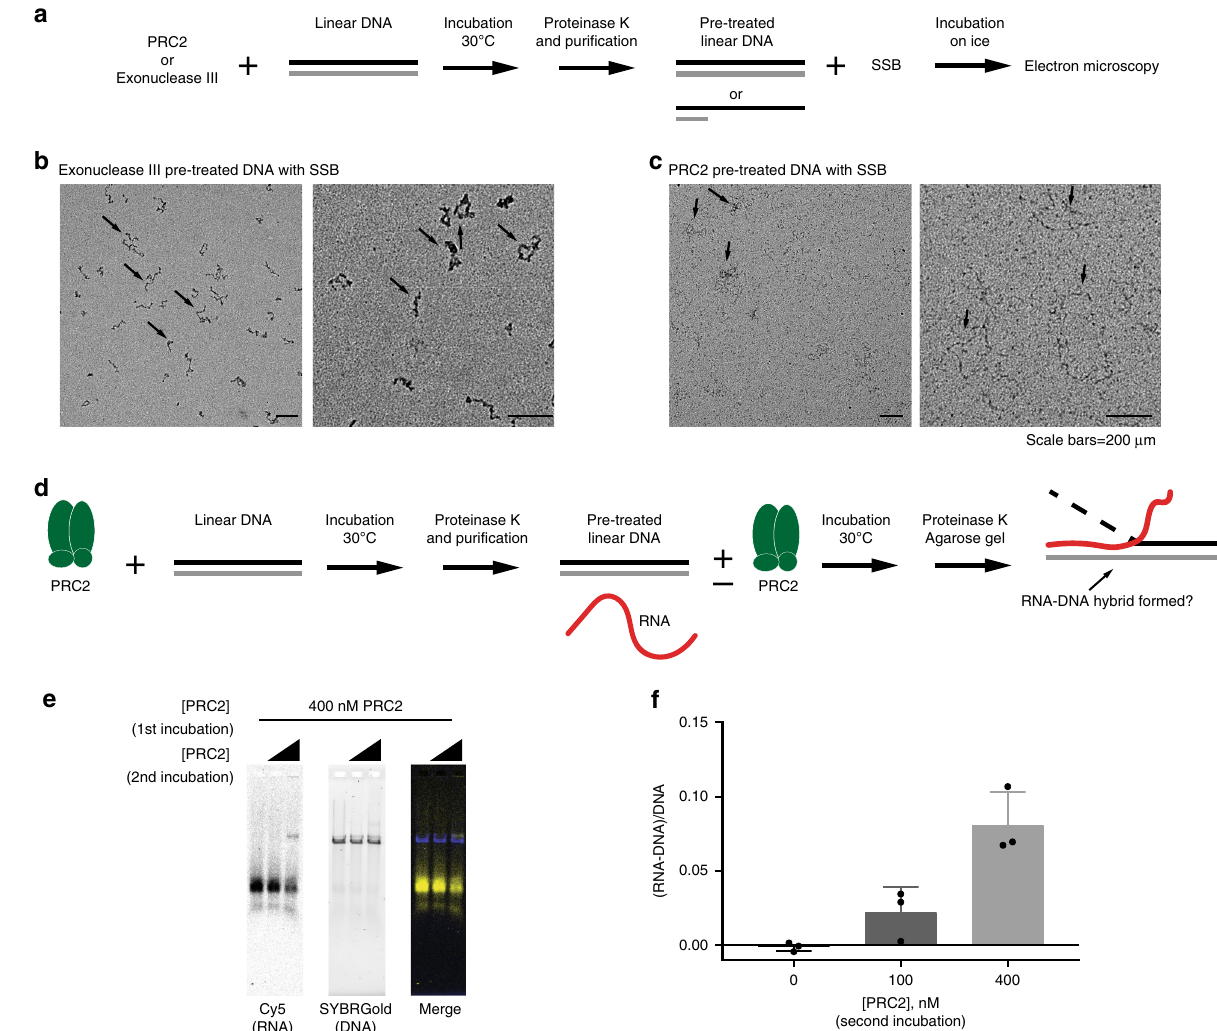
Fig. 4 Nuclease contamination cannot explain RNA – DNA hybrid formation by PRC2. a Scheme of experiment to test whether PRC2 generate a long ssDNA fi lament. Linear DNA was incubated with PRC2 or exonuclease III and puri fi ed. SSB protein was added to pre-treated DNA and samples were visualized by electron microscopy. b , c Representative EM pictures of DNA pre-treated with Exonuclease III ( b ) or with PRC2 ( c ). Arrows indicate DNA with ( b ) or without ( c ) SSB coating. d Scheme of experiment to test whether pre-incubation of DNA with PRC2 allows RNA – DNA hybrid formation in the absence of PRC2.is suf fi cient. e , f Representative gel ( e ) and quanti fi cation ( f ) of strand exchange reactions using DNA that was pre-treated with PRC2 (400 nM) as the substrate. n = 3. Graph shows the mean + / − S.E.M. Source data are provided in Source Data